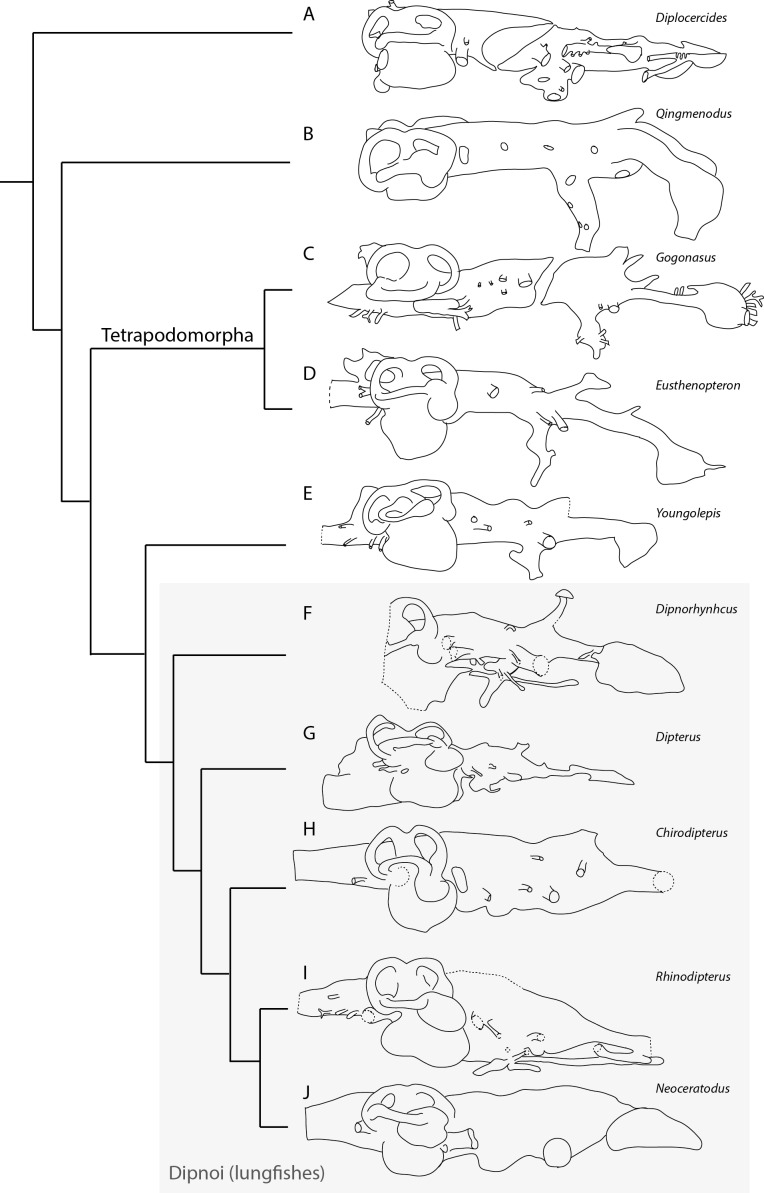
Phylogenetic relationships of selected sarcopterygians as interpreted from cranial endocast morphology.(A) the Late Devonian coelacanth Diplocercides kayseri (from Stensiö, 1963, Fig. 45); (B) the Early Devonian onychodont Qingmenodus yui (from Lu et al., 2016b, Fig. 2); the Late Devonian tetrapodomorphs (C) Gogonasus andrewsae (from Holland, 2014, Figs. 22 and 23); (D) Eusthenopteron foordi (Stensiö, 1963, Fig. 50); (E) the Early Devonian dipnomorph Youngolepis praecursor (from Chang, 1982, Fig. 19); (F) the Early Devonian dipnoan Dipnorhynchus sussmilchi (ANU 18815); (G) the Middle Devonian dipnoan Dipterus valenciennesi (from Challands, 2015, Fig. 9); the Late Devonian dipnoans (H) Chirodipterus wildungensis (from Säve-Söderbergh, 1952, Fig. 9); (I) Rhinodipterus kimberleyensis (WAM 09.6.149); and (J) the extant Australian lungfish Neoceratodus forsteri (from Clement et al., 2015, Fig. 6).